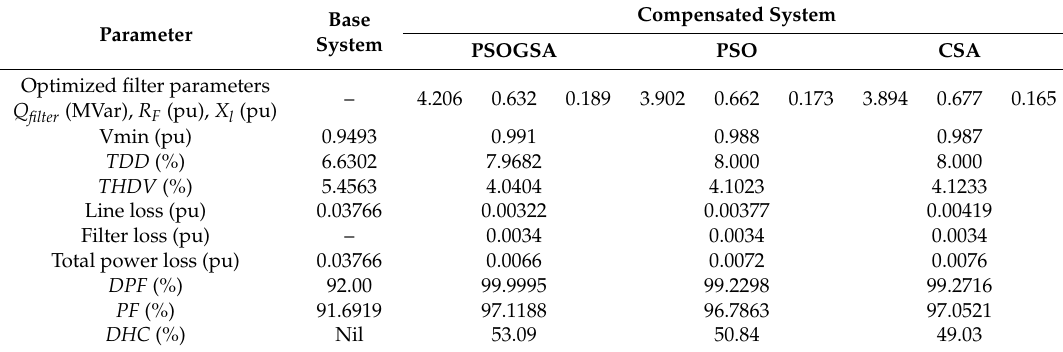
Table 2. Operational parameters and deterministic HC (DHC) results obtained using the designed